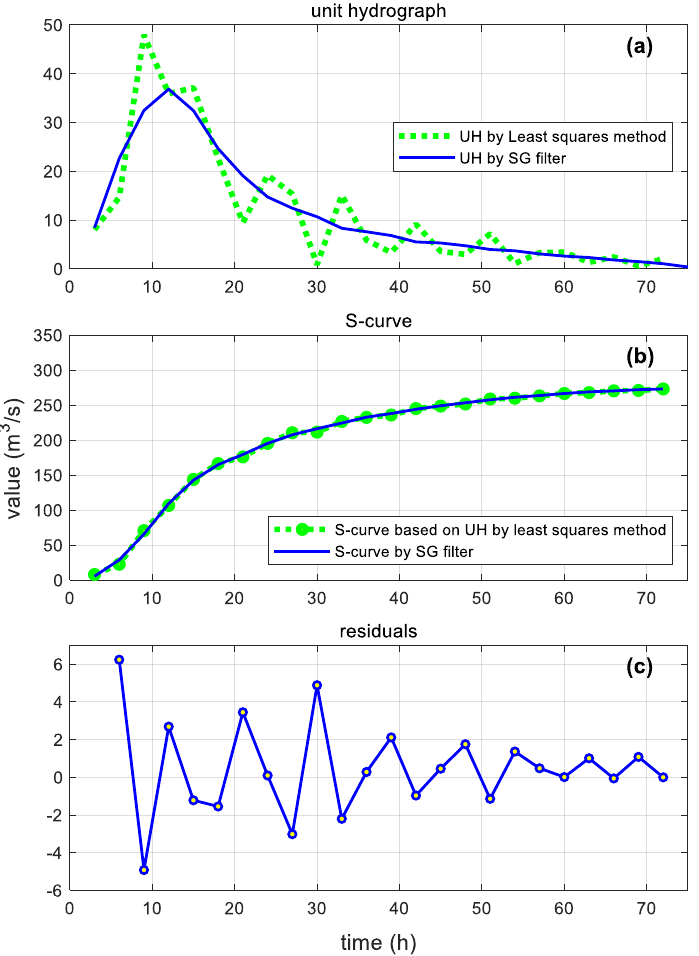
Figure 4. Hydrographs and S-curves by OLS and the SG filter (in the Nenagh River basin): ( a ) unit hydrographs before and after the application of the SG filter; ( b ) S-curves before and after the application of the SG filter; ( c ) difference between S-curve ordinates after the application of SG filter.